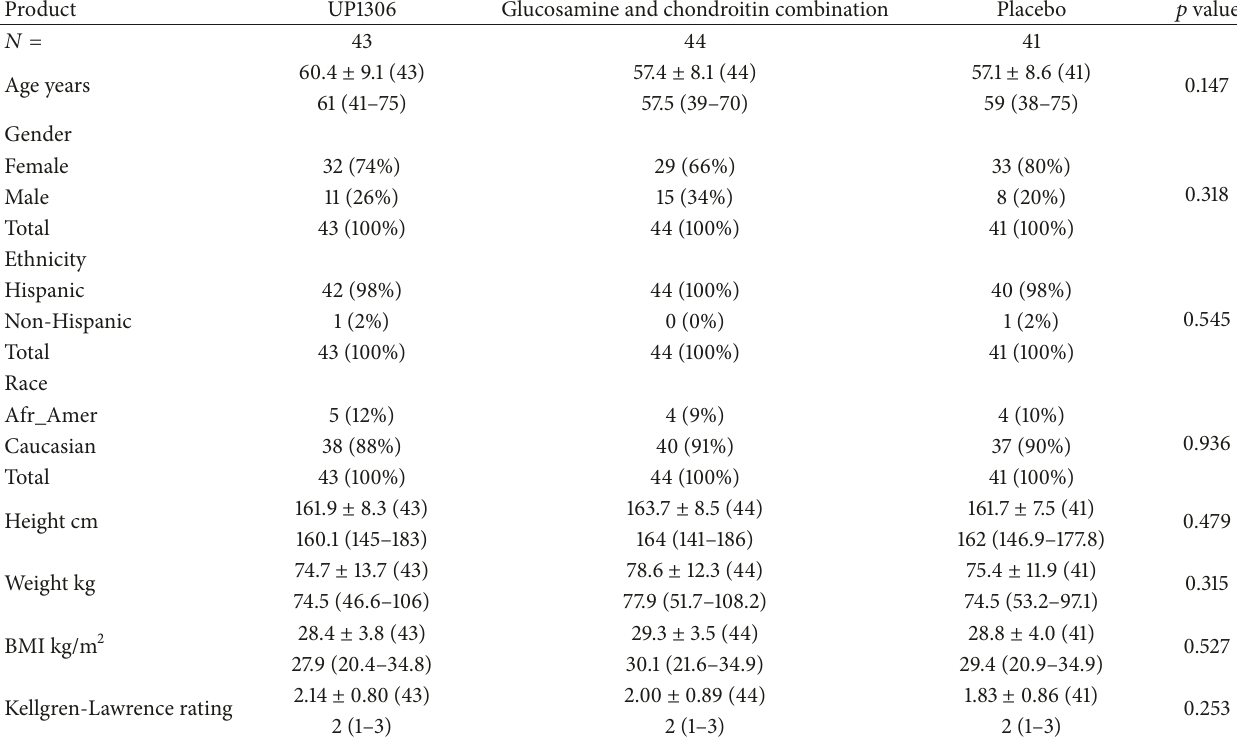
Table 1: Baseline characteristics of subjects.